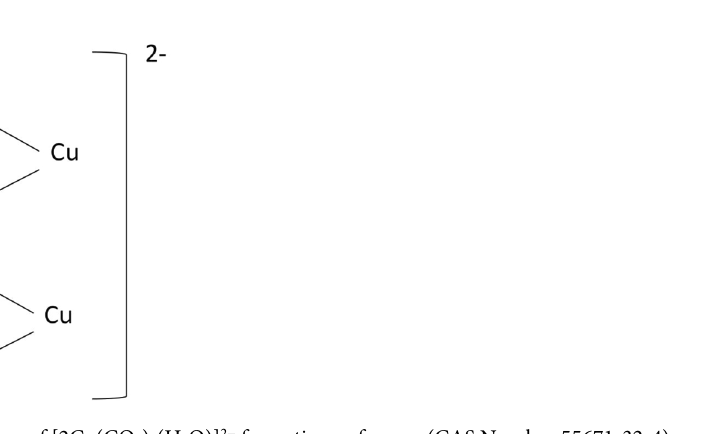
Figure 11. Predicted structure of [2Cu(CO 2 ) 2 (H 2 O)] 2− formation; reference (CAS